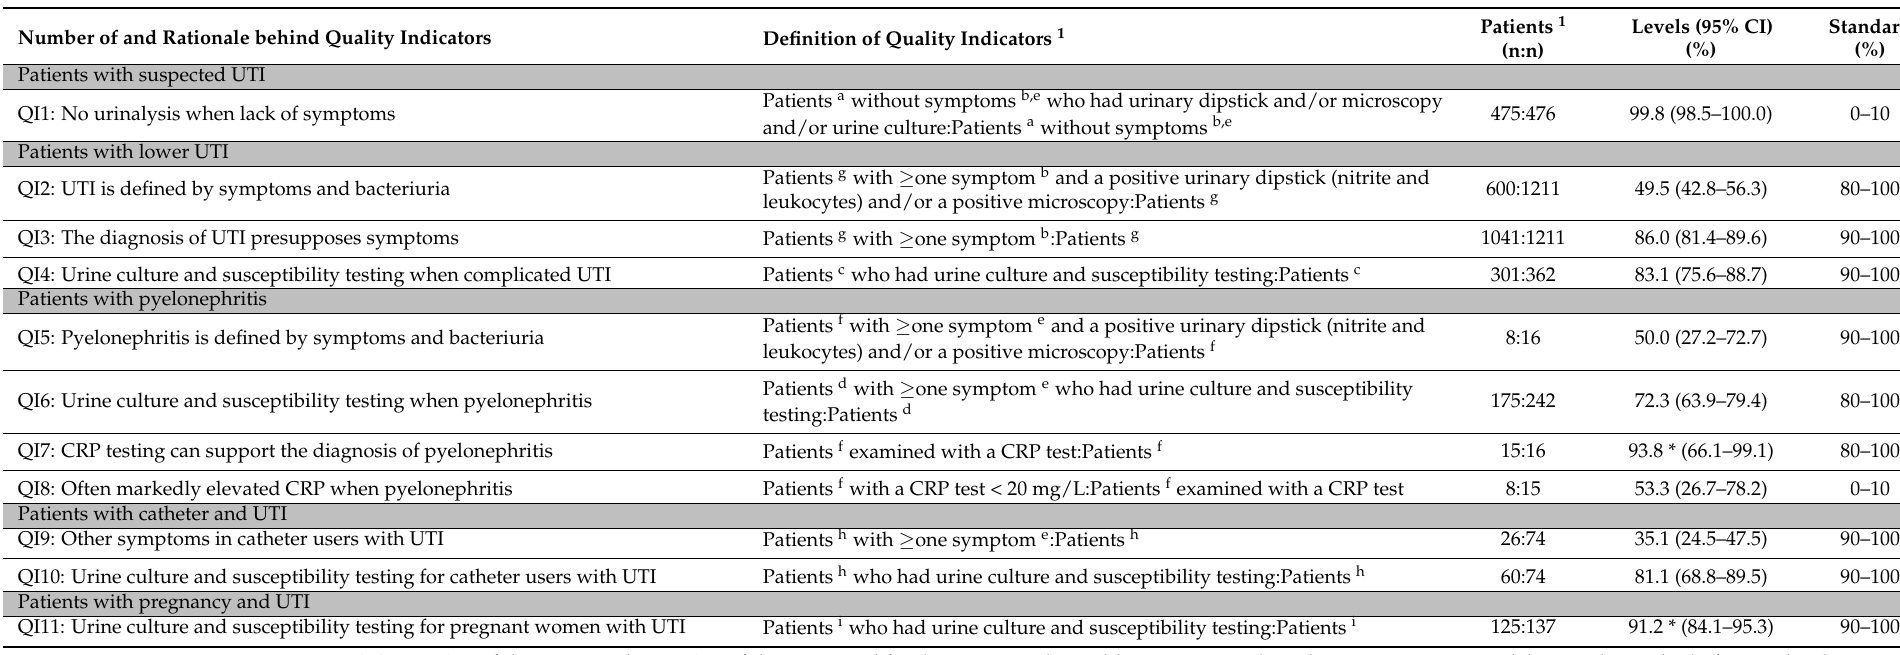
Table 1. Levels and standards for eleven quality indicators focusing on the diagnostic process of urinary tract infections in Danish general practice (2020). Number of and Rationale behind Quality